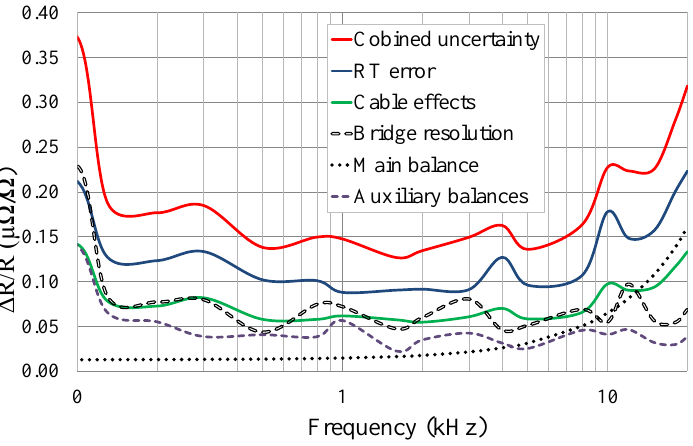
Figure 10. Standard uncertainty components (k = 1) of the 10:1 ratio measurement between the RC-10K-D5e and the